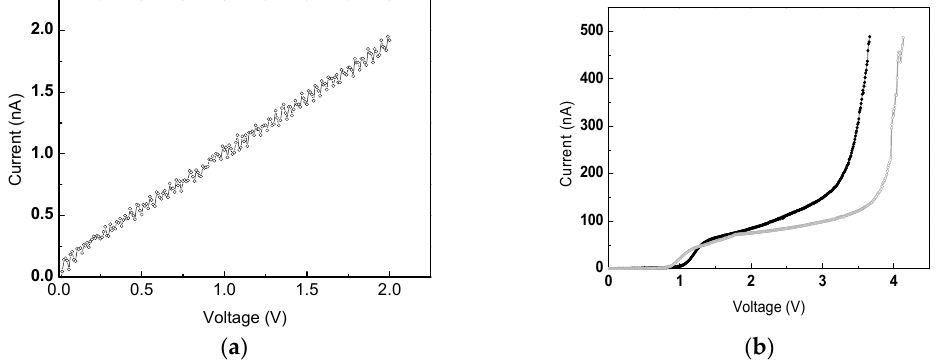
Figure 3. The electric measurement of the ionization gas detection device: ( a ) current versus voltage curve recorded by loading bias on both terminals of the single nanowire; ( b ) I - V data captured by sweeping voltage between the nanowire and substrate in the gas environment of N 2 (grey) and NO 2 diluted in N 2 (black).